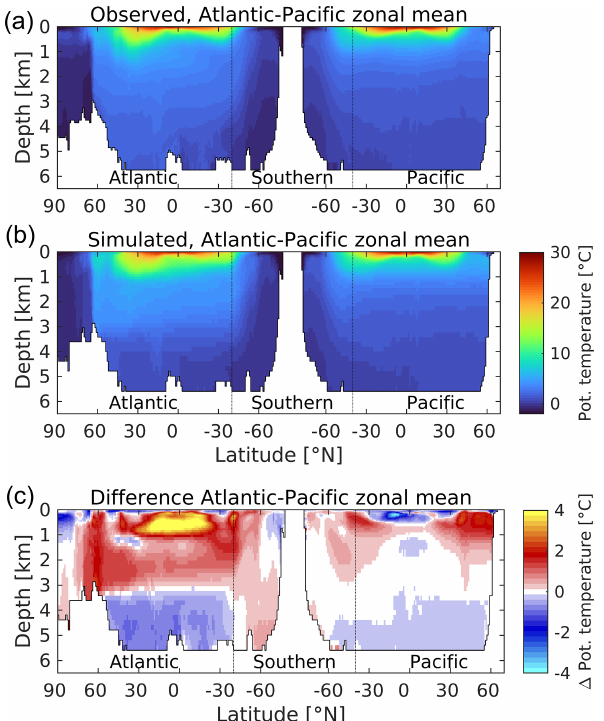
Figure 6. A “thermohaline circulation” section of observed (a) and modelled (b) zonal average potential temperature. Difference (simulated–observed) is shown in (c) . The section tracks south- wards “down” the Atlantic basin from the Arctic to the South- ern Ocean, before tracking northwards “up” the Pacific basin from the Southern Ocean to the Bering Strait. The aim is to capture the stereotypical transport of deep water from its formation as a “young” water mass in the high North Atlantic through to its end as an “old” water mass in the North Pacific. Dotted lines mark the “boundaries” of the Southern Ocean at 40 ◦ S in each basin. Poten- tial temperature in ◦ C.